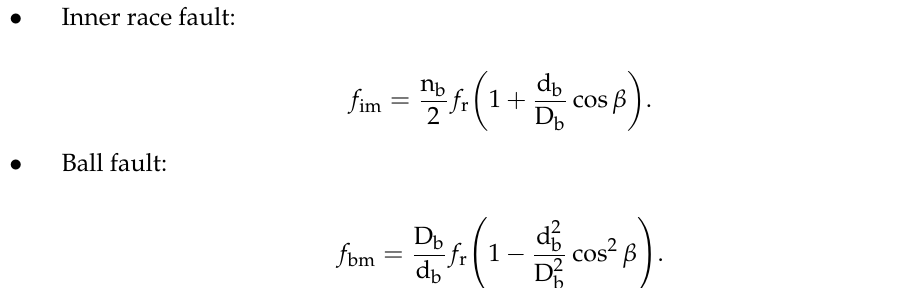
Figure 2. Rolling bearing and typical failure modes.